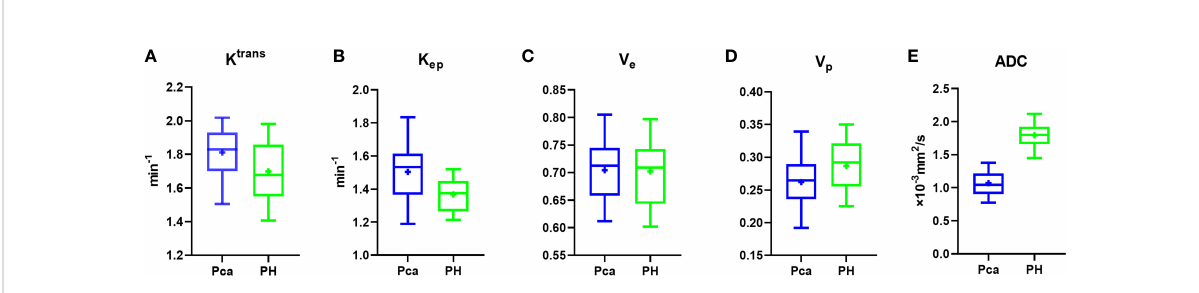
FIGURE 3 Box plot of vascular permeability parameters and ADC. (A – E) K trans (A) , K ep (B) , and ADC (E) differed signi fi cantly between PCa and BPH patients, whereas V e (C) and V p (D) were similar between the 2 groups.